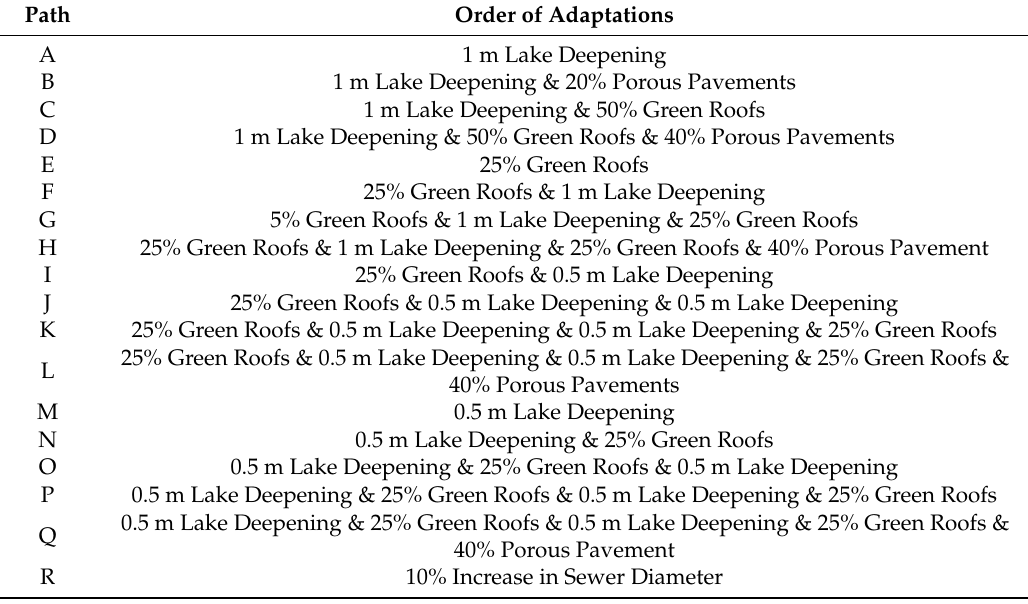
Table 1. Order of adaptations for each